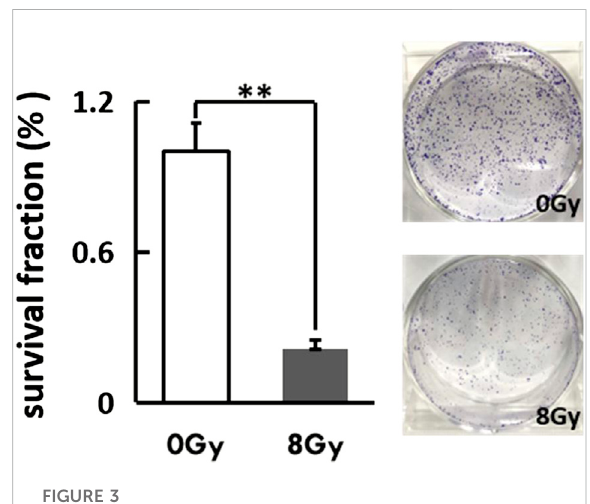
FIGURE 3 Theirradiatedcellswerereseededatalowdensity (400cells/ well) in a petri dish (D = 3 cm). The Coomassie-staining and colonies ( ≥ 50 cells) counting were performed after 2 weeks. Representative photographs of colonies and the colony fraction were